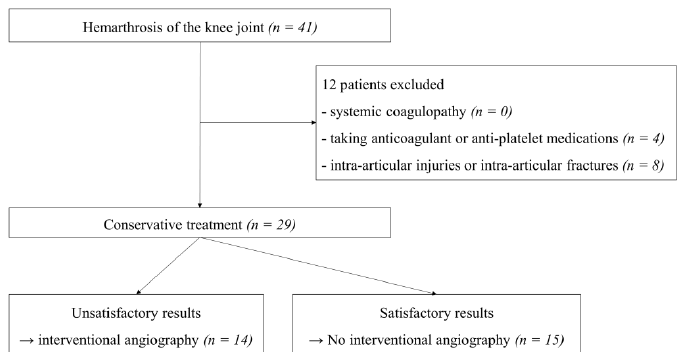
Figure 1. Flow chart of study population selection.